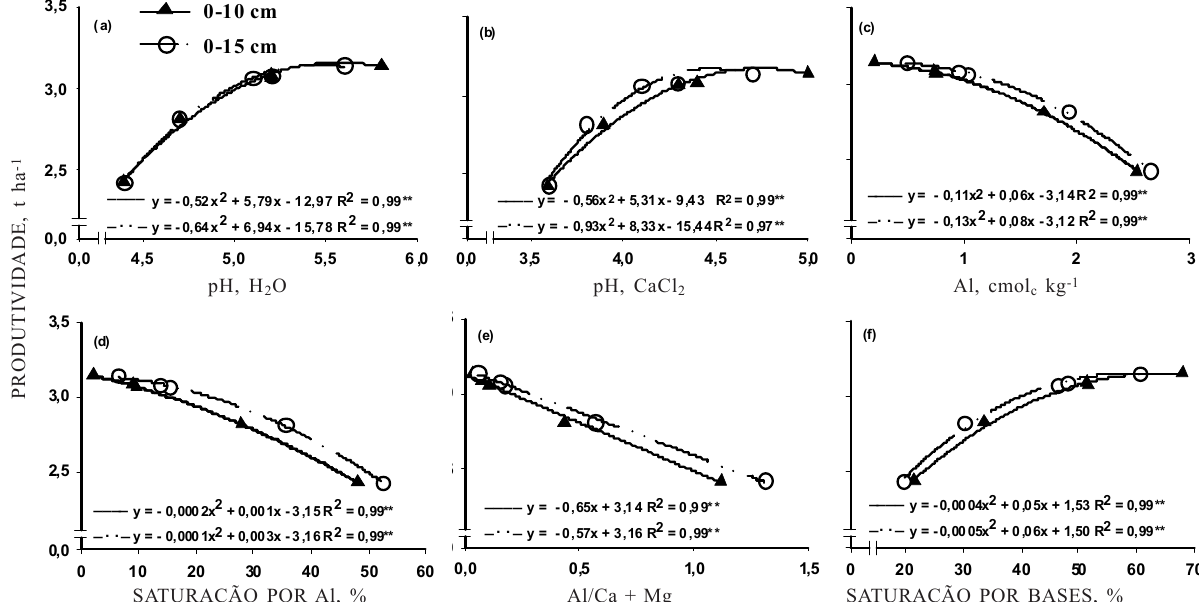
O (a), pH CaCl (b), Al trocável (c) saturação por 2 2